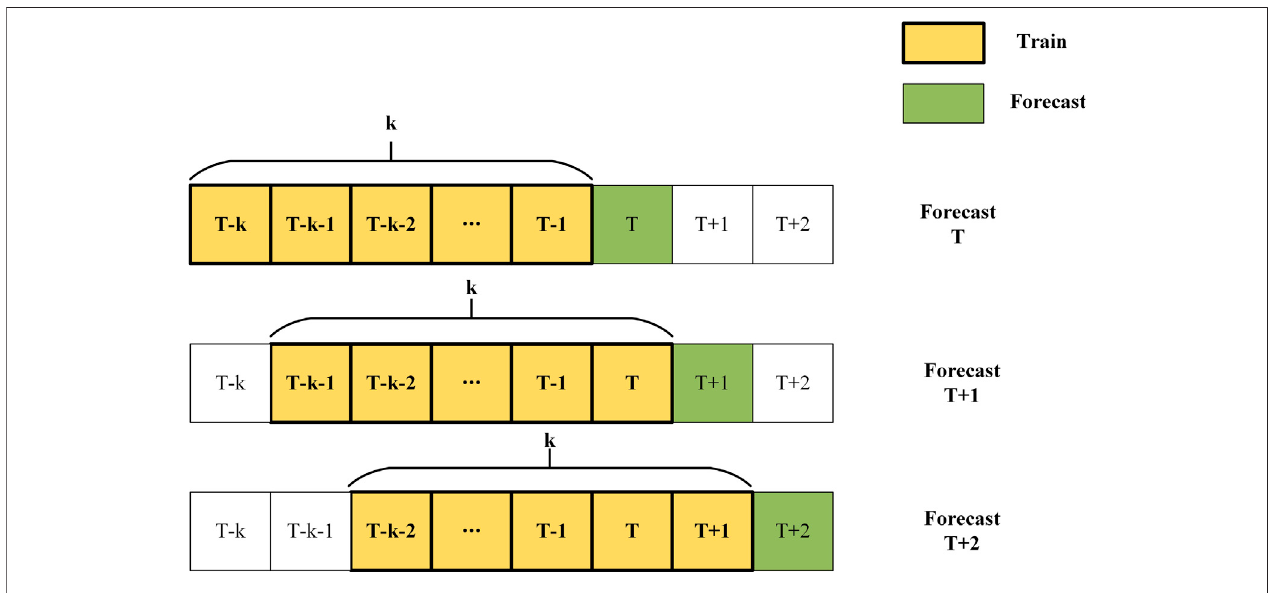
FIGURE 2 | Dynamic division of training dataset and test dataset.